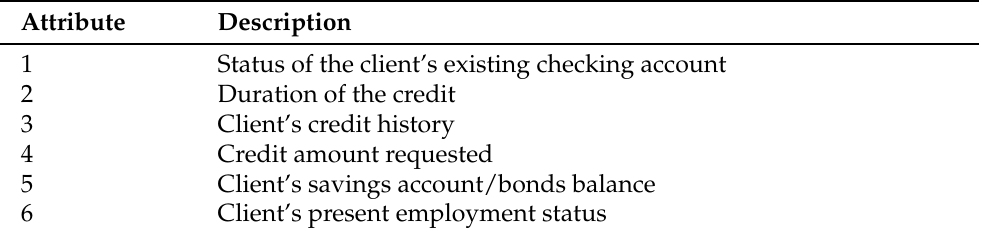
Table A1. Description of the variables included in the German credit